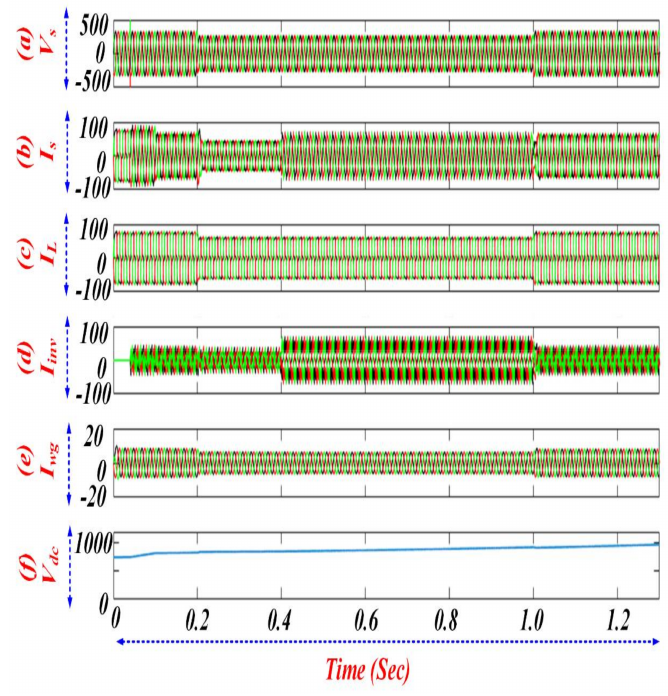
Figure 7. Operation of PV-STATCOM: ( a ) source voltage; ( b ) source current; ( c ) load current; ( d ) PV-STATCOM injected current; ( e ) wind generator current; and ( f ) DC bus capacitor voltage.